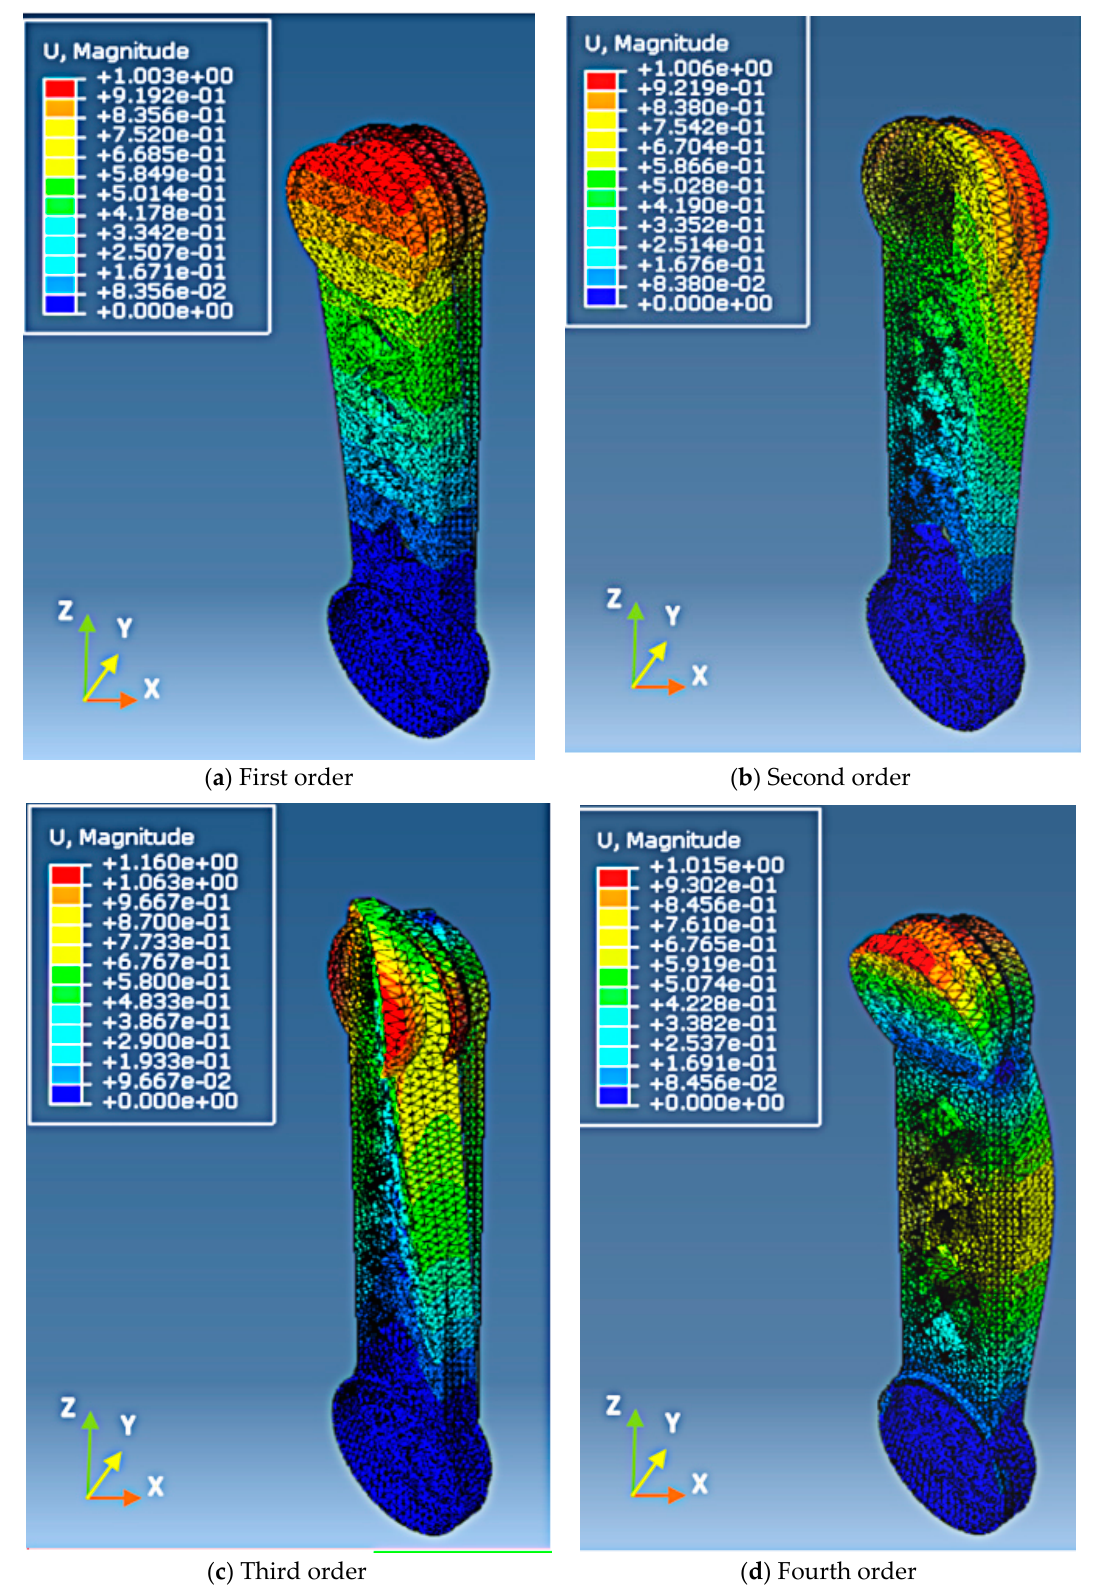
Figure 26. The first four order vibration modes of the optimized upper arm, ( a ) First order, ( b ) second order, ( c ) third order, ( d ) fourth order.